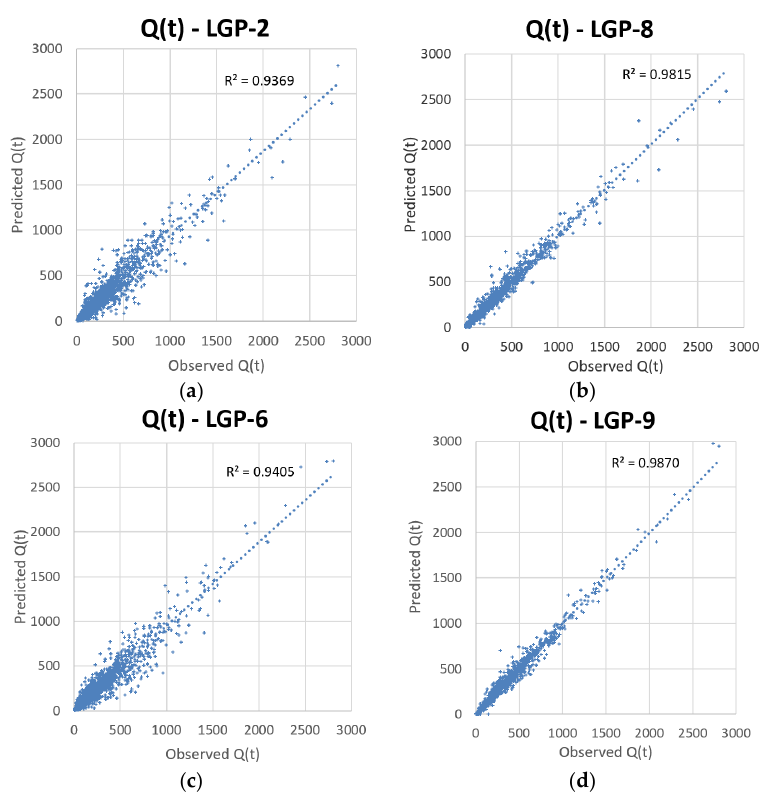
Figure 7. Scatter plots of observed vs. predicted for select models. An improved fit can be seen in the EEMD-LGP (LGP-8) and EEMD-SOM-LGP (LGP-9) models for capturing streamflow. ( a ) LGP as standalone application; ( b ) SOM-LGP; ( c ) EEMD-LGP; ( d ) EEMD-SOM-LGP.